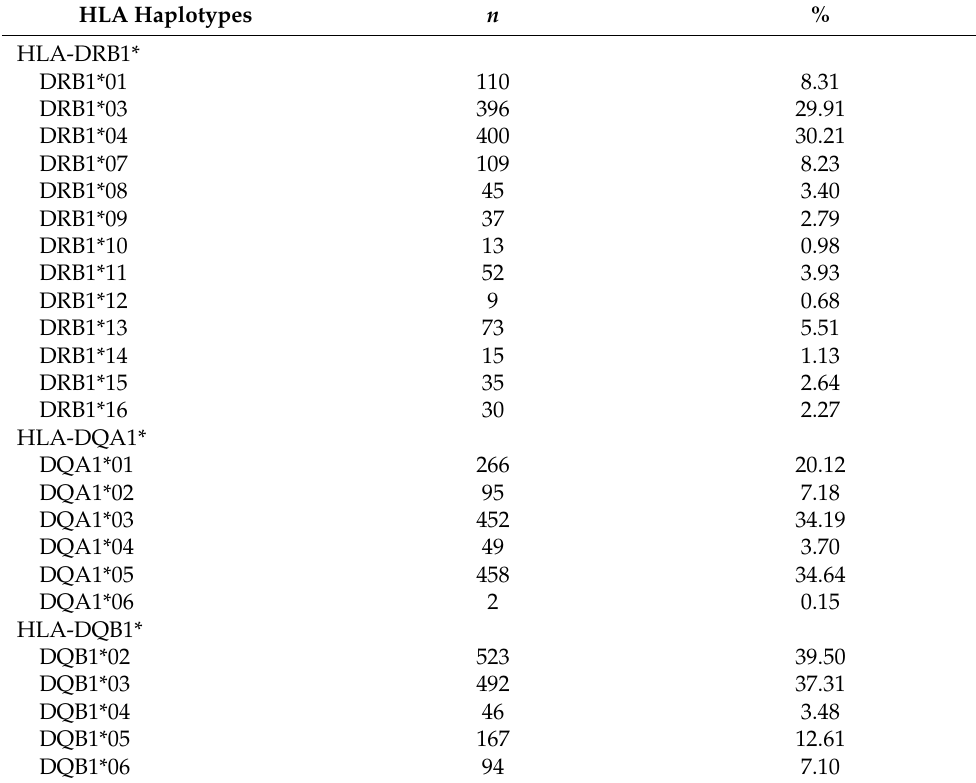
Table 2. HLA-DRB1 -QA1 and -DQB1 allele’s frequencies in the study sample of Brazilian patients with type 1